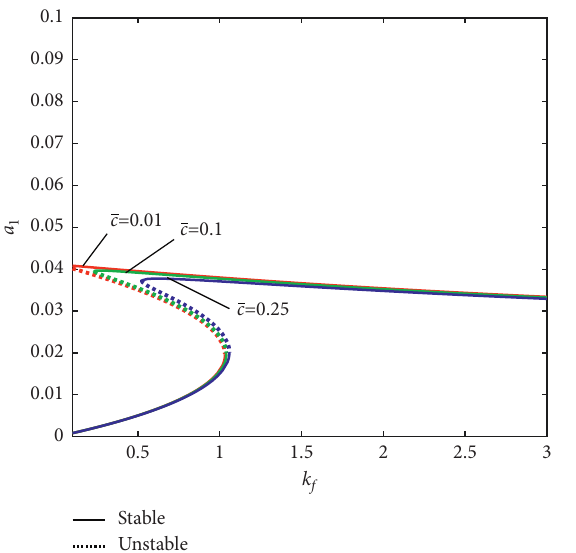
Figure 23: Amplitude versus cutting force coefficient with different damping coefficients ( σ � 2, θ � 0 ° , L/d � 10, case I).